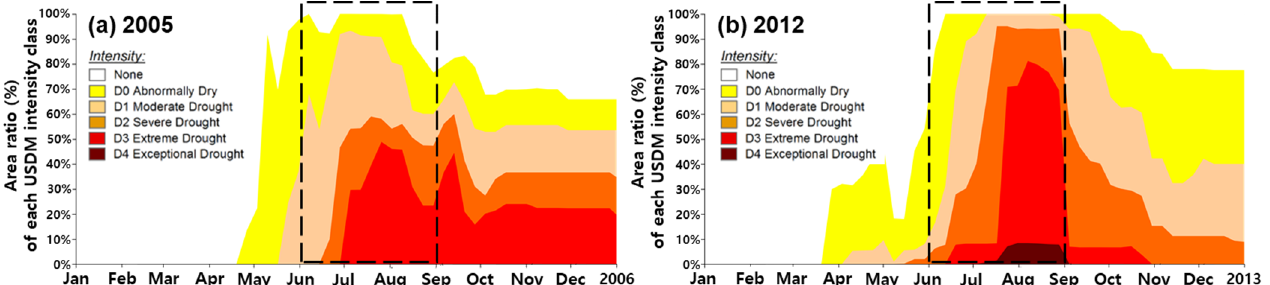
Figure 6. Monthly drought status in Illinois in ( a ) 2005 and ( b ) 2012